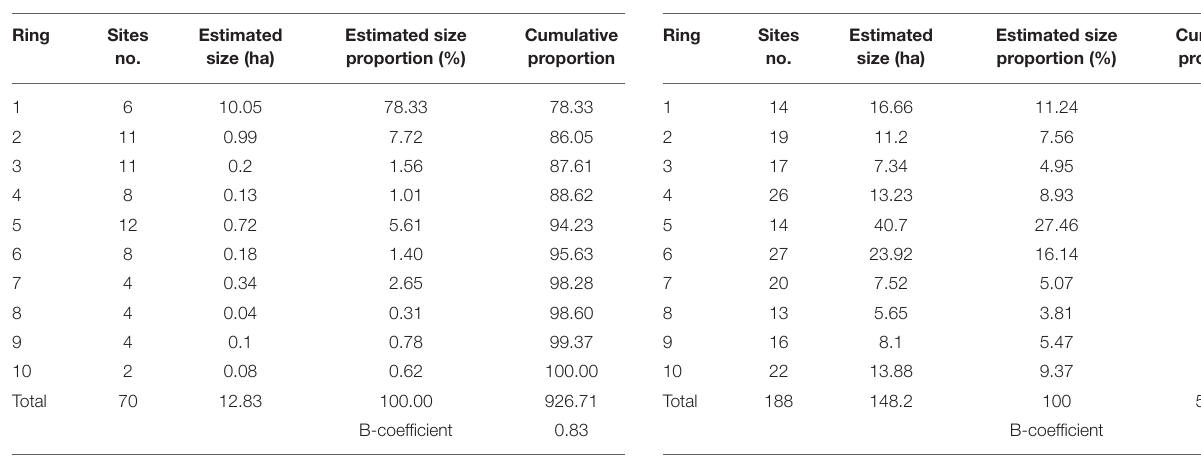
TABLE 10 | Calculation of B-coefficient for Murlo in the Archaic period. Ring Sites no.